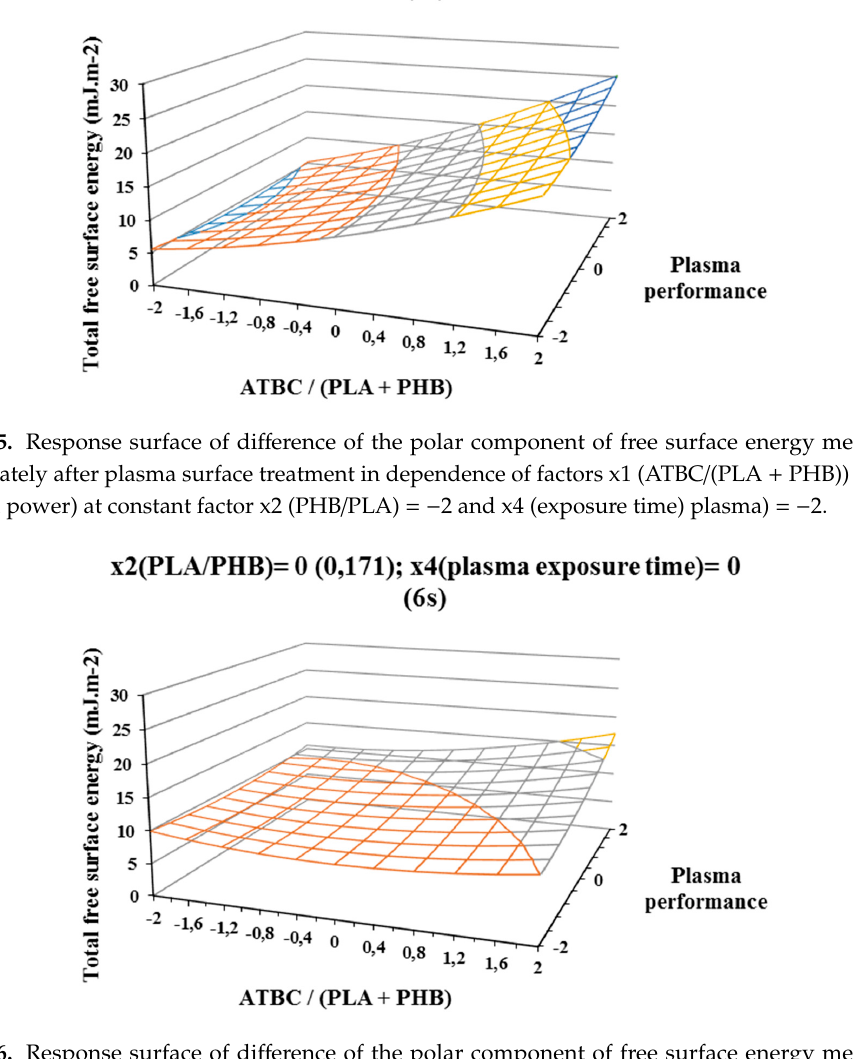
Figure 7. Response surface of difference of the polar component of free surface energy measured immediately after plasma surface treatment in dependence of factors x1 (ATBC/(PLA + PHB)) and x3 (plasma power) at constant factor x2 (PHB/PLA) = 2 and x4 (plasma exposure time)) = 2 . 3.2. Total Free Surface Energy Evaluated after 5 h of Plasma Treatment The change in the total free surface energy difference after 5 h of plasma treatment was also studied. In Figure 8, Figure 9, and Figure 10, total free surface energy result areas measured 5 h after activation are observed depending on factors x1 (ATBC/(PLA + PHB)) and x3 (plasma power) at a constant factors x2 (PHB/PLA) and x4 (plasma exposure time). At the lowest values of the concentration of PHB and the time of plasma discharge exposure, a decrease in the total free surface energy difference with increasing ATBC content and decreasing plasma power was observed in its entirety. At the mean values of constant factors, the local minimum is visible in the middle of the result area (Figure 9). At high concentration of PHB and plasma exposure time, an increase of total surface energy difference is observed with increasing ATBC content and decreasing plasma discharge